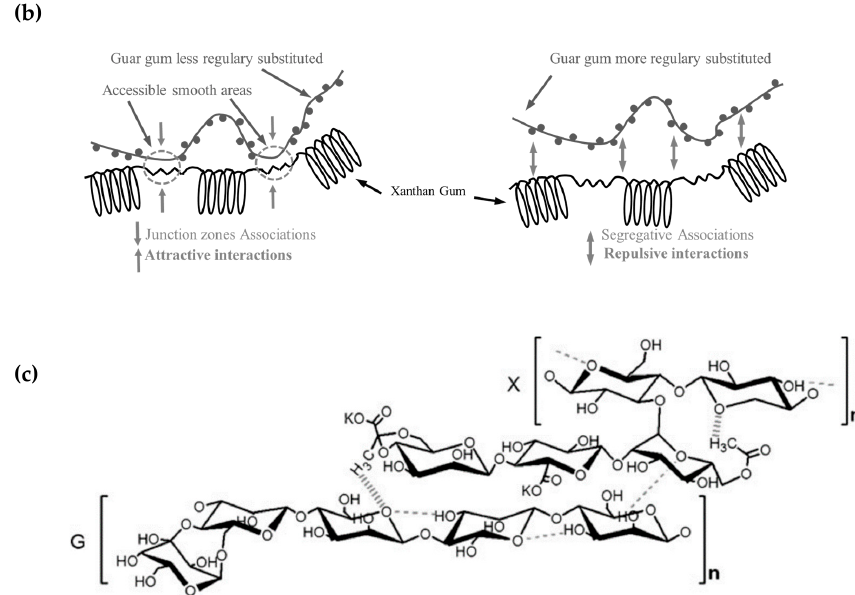
Figure 3. Different models of Xanthan Gum—Galactomannan synergies [98]: ( a ) Unilever model [99], ( b ) Norwich model [100], ( c ) Tako model [101] (G, galactomannan; X, xanthan gum).